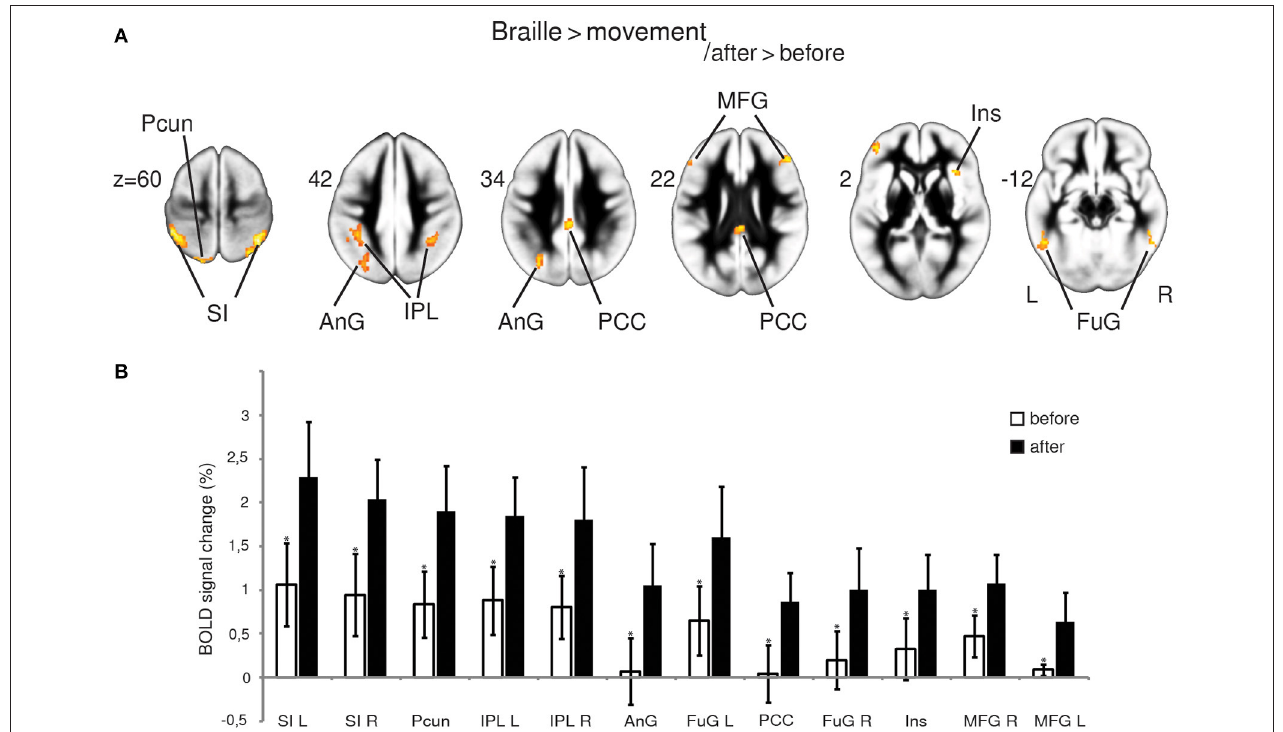
FIGURE 2 | fMRI results. Statistical parametric maps of the functional plasticity induced by Braille training revealed by Braille > movement after vs. before training comparison, FWE corrected at p < 0.05 (A) ; percentage of BOLD signal change (B) . Percentage of signal change was calculated individually within a spherical volume of interest with a diameter of 10 mm (* p < 0.05, paired t -test). Abbreviations: AnG—angular gyrus, FuG—fusiform gyrus, Ins—insula, IPL—inferior parietal lobule, MFG—medial frontal gyrus, PCC—posterior cingulate cortex, Pcun—precuneus, SI—primary somatosensory cortex, L—left, R—right.